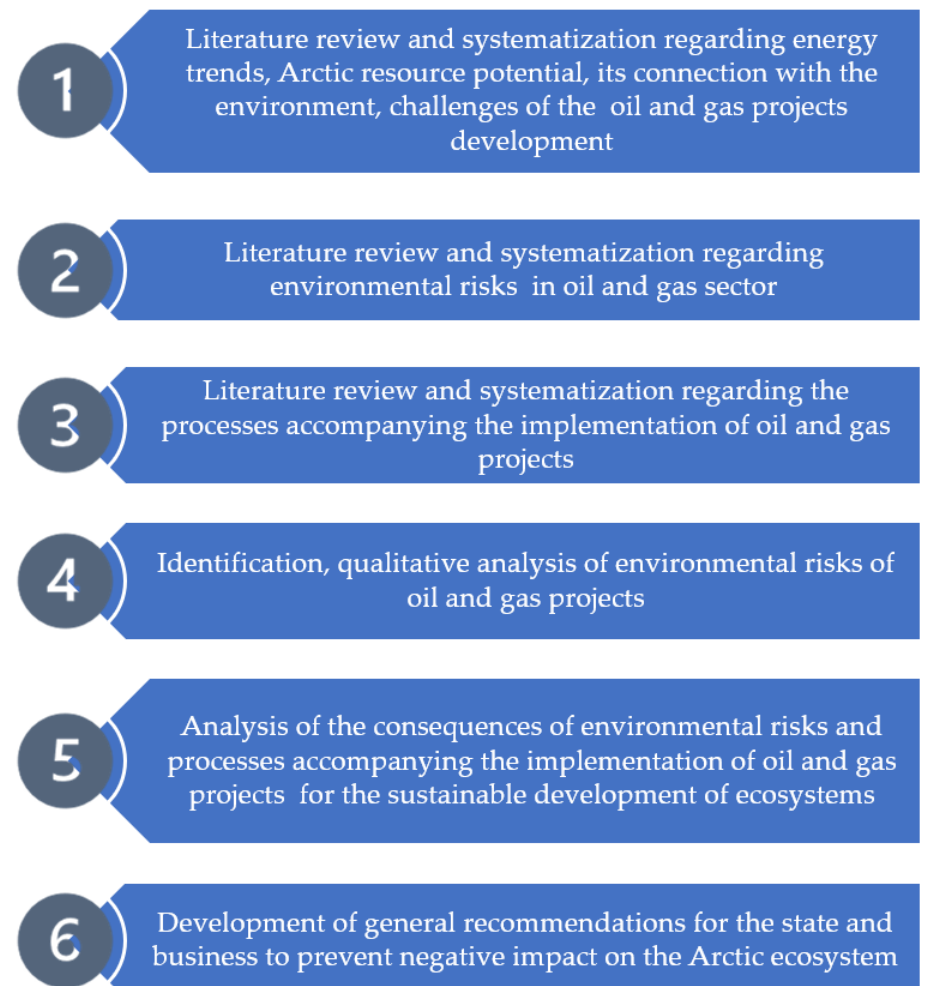
Figure 1. The structure of the present research (created by the authors).